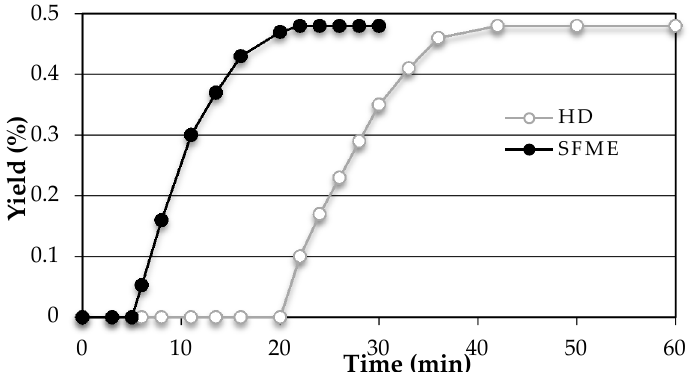
) extraction of EO from sweet (cid:35)